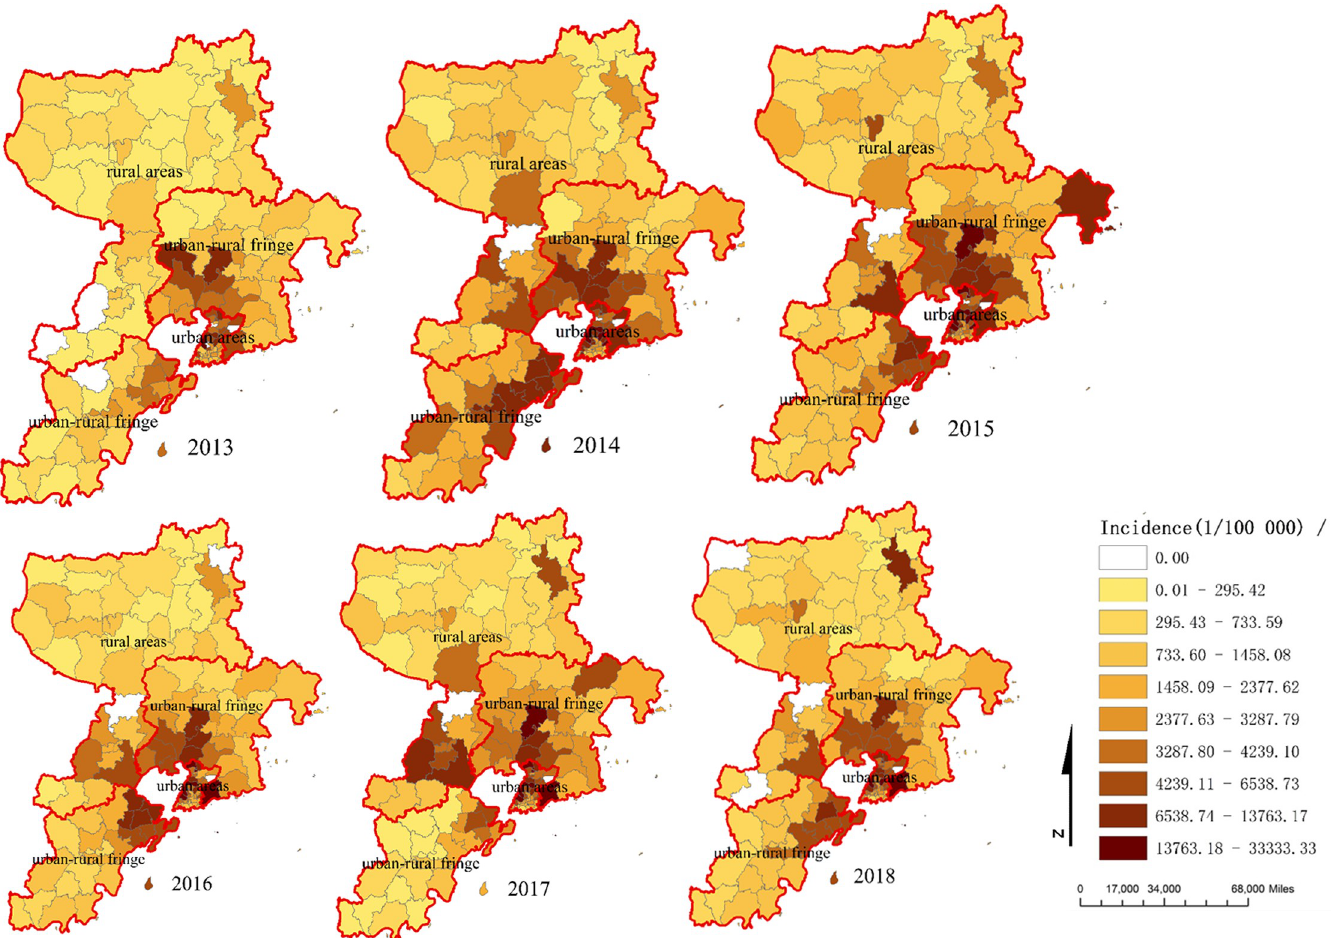
Fig 2. The incidence rate of HFMD among children aged 0–5 year old at street/township level in Qingdao City, 2013–2018.